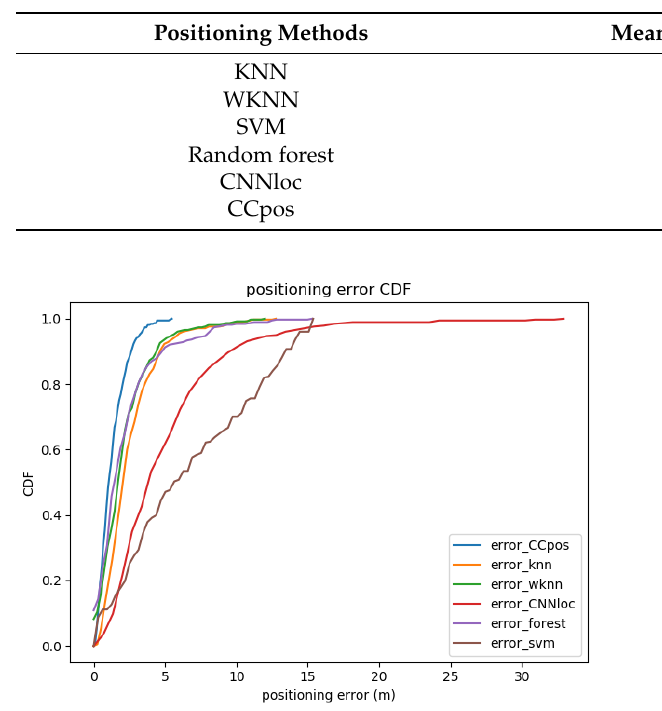
Table 6. Mean positioning error with different methods on the Alcala Tutorial 2017 dataset.